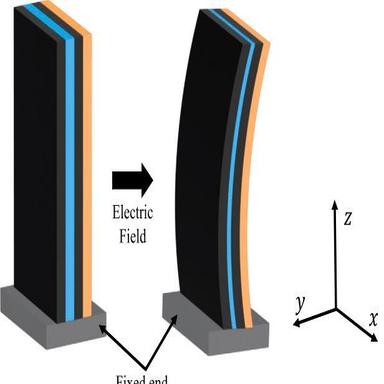
Working principle of the soft actuator. The actuator composed by the composite layer (blue), surrounded by the carbon black-based electrodes (black), and held by the passive layer (orange), bends when an electric field is applied.